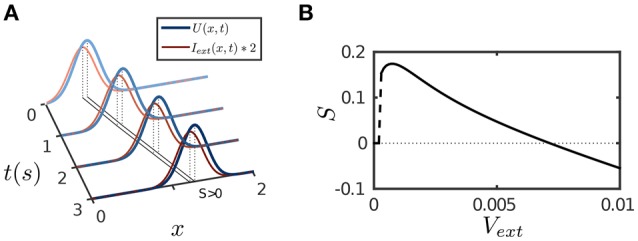
Tracking performance of the network. The moving input is given by Equation (8). (A) An example of anticipative tracking of the network. vext = 0.8/s. For the illustration purpose, the 2D bump is projected on the normal of the moving direction, and the external input strength is scaled up by twofold. (B) The condition for anticipative tracking. Anticipation occurs when Svext > 0, where S is the separation between the network bump and the external input. When the speed is too small, S = 0 implies no tracking at all; and when the speed is too large, Svext < 0 implies lagging. Other parameters are the same as Figure 2.